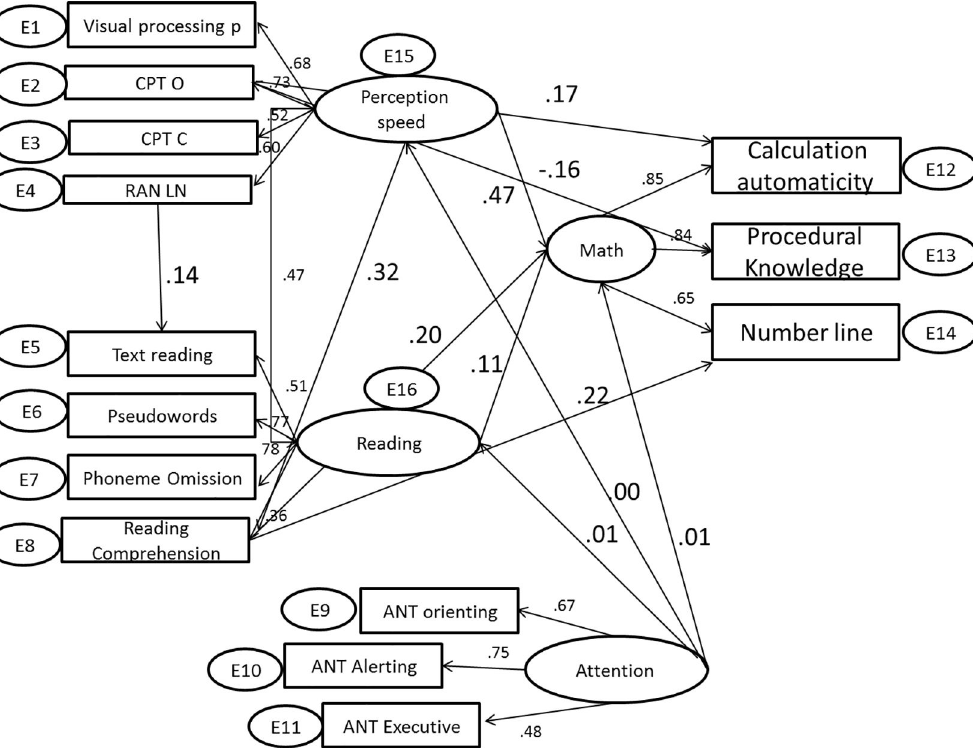
Figure 4. Testing the role of attention as a potential explanation of reading and perception speed. Visual processing P = visual processing parallel. CPT O = continuous performance task omission. CPT C = continuous performance task commission. RAN LN = rapid automatized naming letter numbers. ANT orienting = attention network test orientation. ANT Alerting = attention network test alertness. ANT executive = attention network test